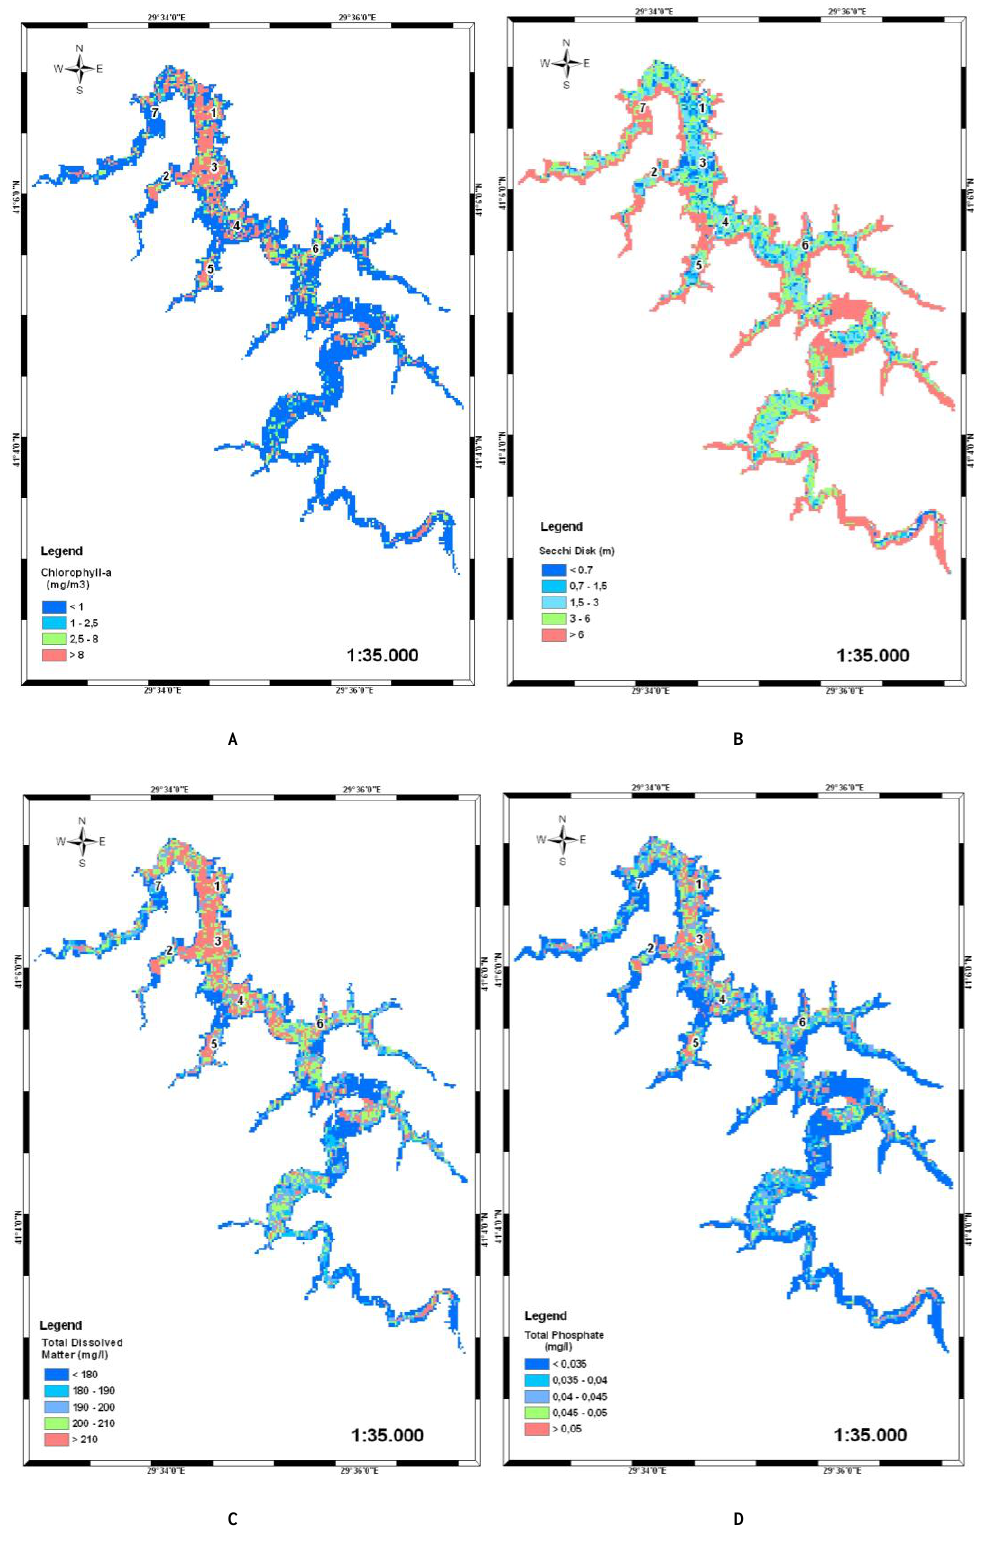
FIGURE 4. WQ images by regression analysis. (A) CHL, (B) Secchi disk, (C) TDM, (D) total phosphate, (E) total nitrate. Continued next